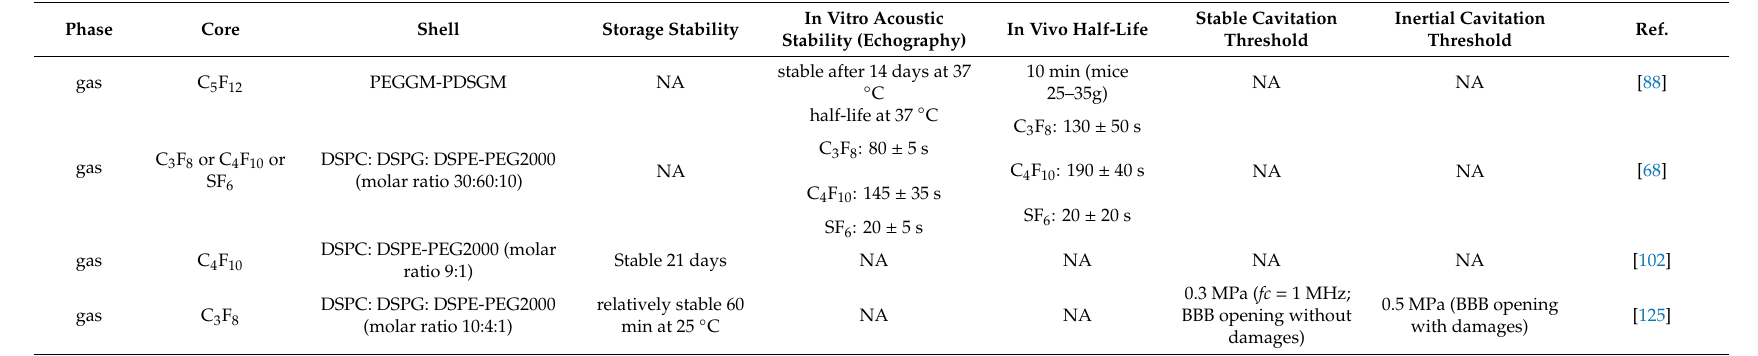
Shell Storage Stability